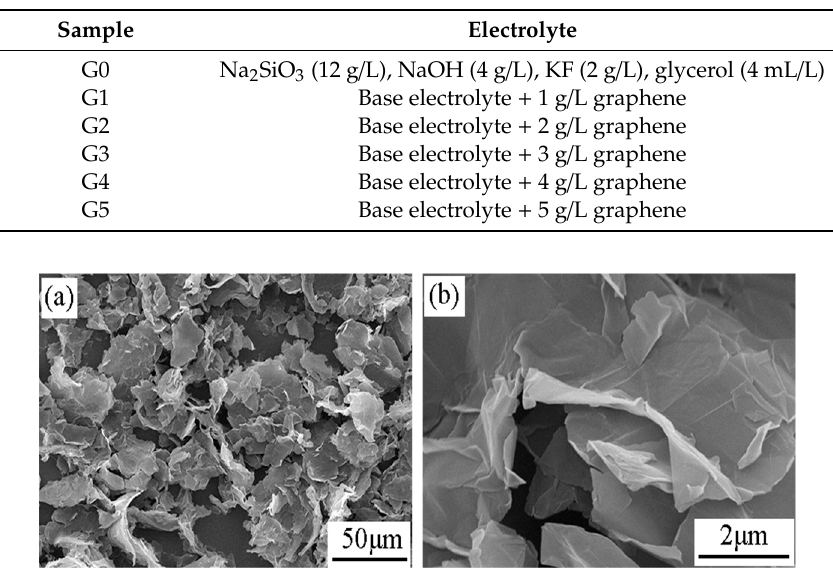
Table 2. The electrolytes used for the formation of the PEO coatings.